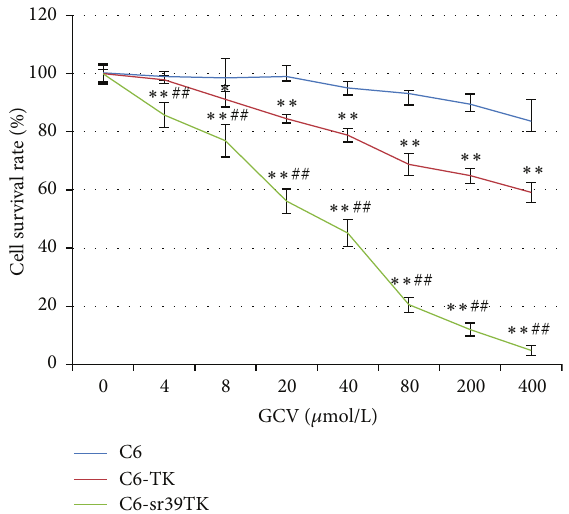
Figure 3: Growth inhibition in cultured C6-TK and C6-sr39TK cells 72 hours after ganciclovir (GCV) administration. Cell survival rate (SR) was measured by MTT assay, which showed SR in C6- TK and, especially, the C6-sr39TK group was significantly decreased in a dose-dependent manner as compared with that of the control ( ∗ 𝑃 < 0.05 versus C6 group; ∗∗ 𝑃 < 0.01 versus C6 group; ## 𝑃 < 0.01 versus C6-TK